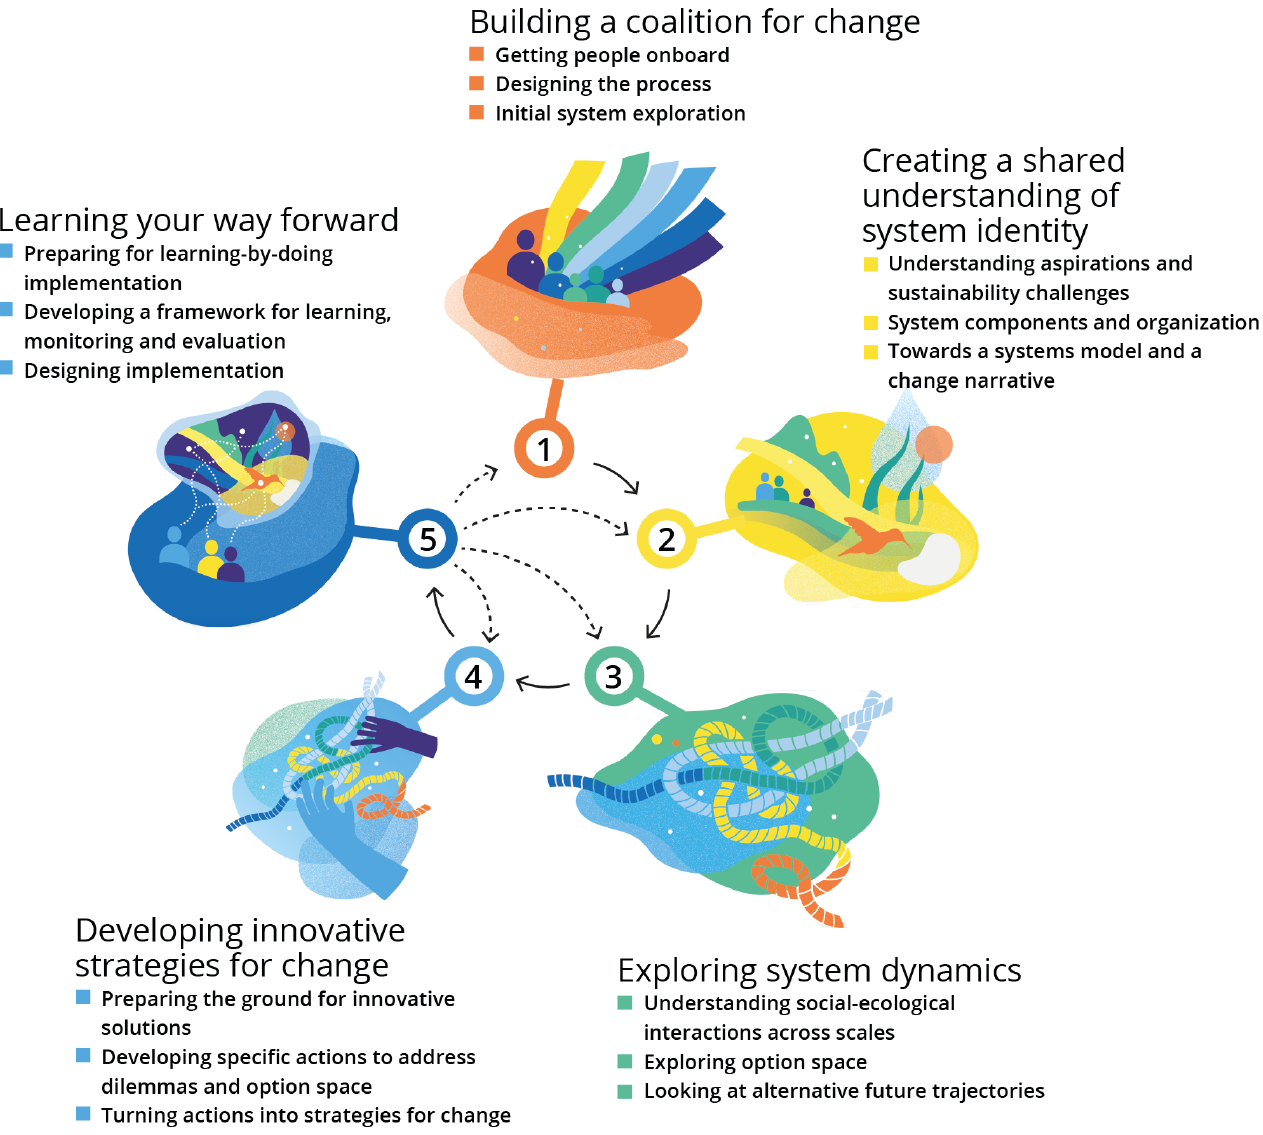
Fig. 6. Wayfinder is an iterative process in five phases that helps users better understand their system, develop innovative strategies for change, and collectively learn their way forward. It starts with the creation of a coalition for change that will lead the process forward, moving on to focus on system identity, explore system dynamics, develop strategies for change, and finally test these strategies in reality and learn the way forward. The lessons learned through implementation will allow users to refine the systems understanding and strategies for change gradually, starting a new iteration of the Wayfinder process. Illustration: E. Wikander/